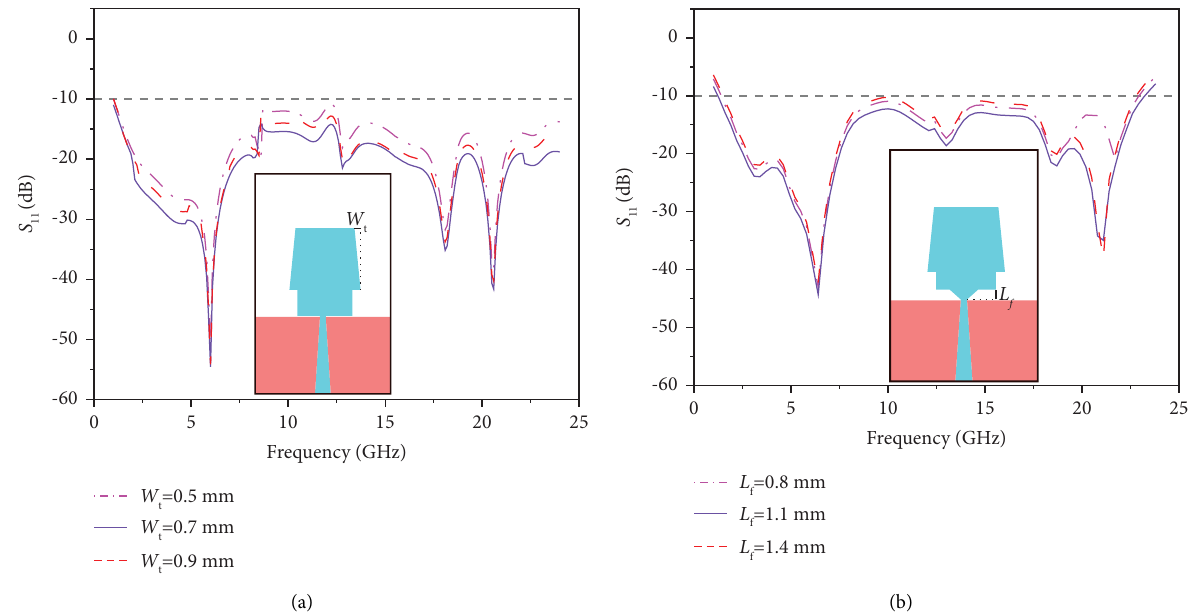
Figure 3: S 11 simulation results of diferent long side values. (a) W t . (b) L f